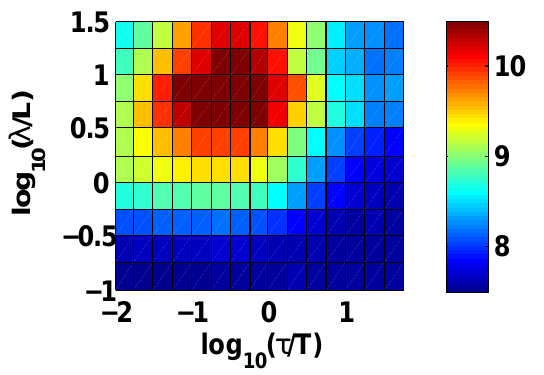
Fig. 5. Mean mixing efficiency ς(τ,λ) [days − 1 ] in terms of FTLE values at the nutrient source Eq. (11) as a function of Eulerian time and length scales ( τ,λ ) for the Gaussian flow, Eqs. (2–4). Set of parameters as in Fig.